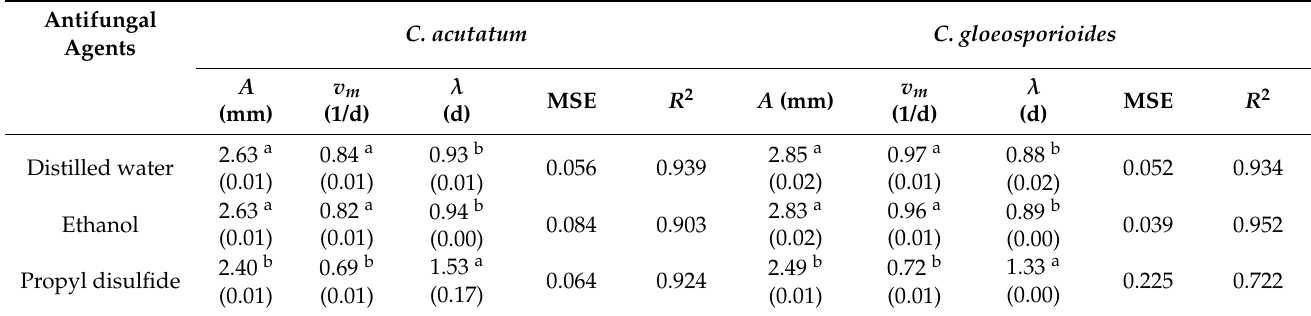
Table 4. Modified Gompertz model parameters for agar diffusion